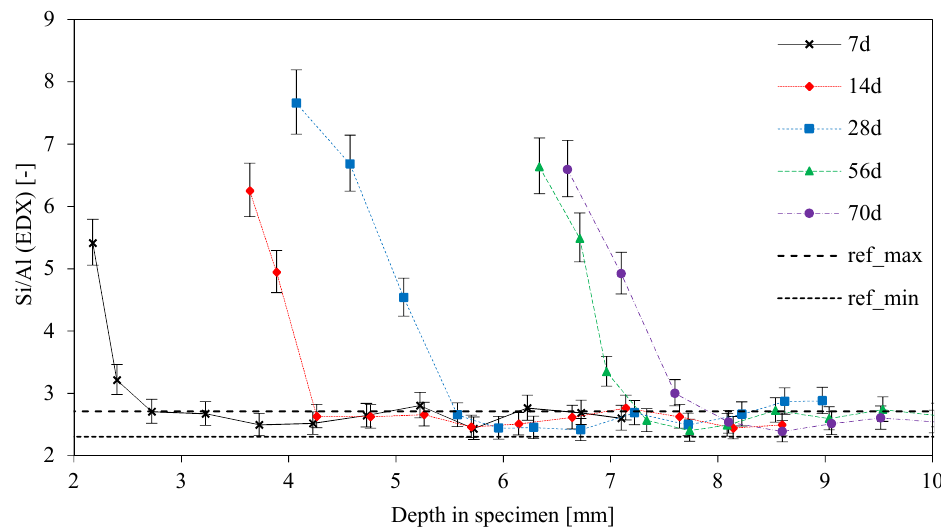
Figure 15. Si / Al ratios calculated by aluminum and silicon concentration from EDX elemental mapping, Figure 15. Si/Al ratios calculated by aluminum and silicon concentration from EDX elemental as a function of depth in the specimen. Curves for di ff erent exposure times up to 70 days and reference mapping, as a function of depth in the specimen. Curves for different exposure times up to 70 days lines ref min and ref max from the original unexposed geopolymer and reference lines ref min and ref max from the original unexposed geopolymer sample.